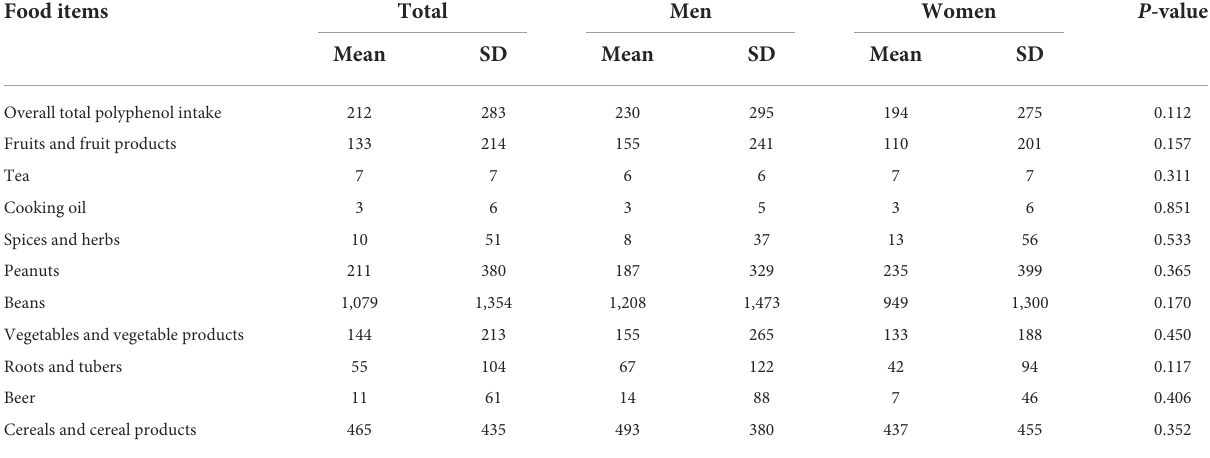
TABLE 6 Usual total polyphenol intake (mg) and related food